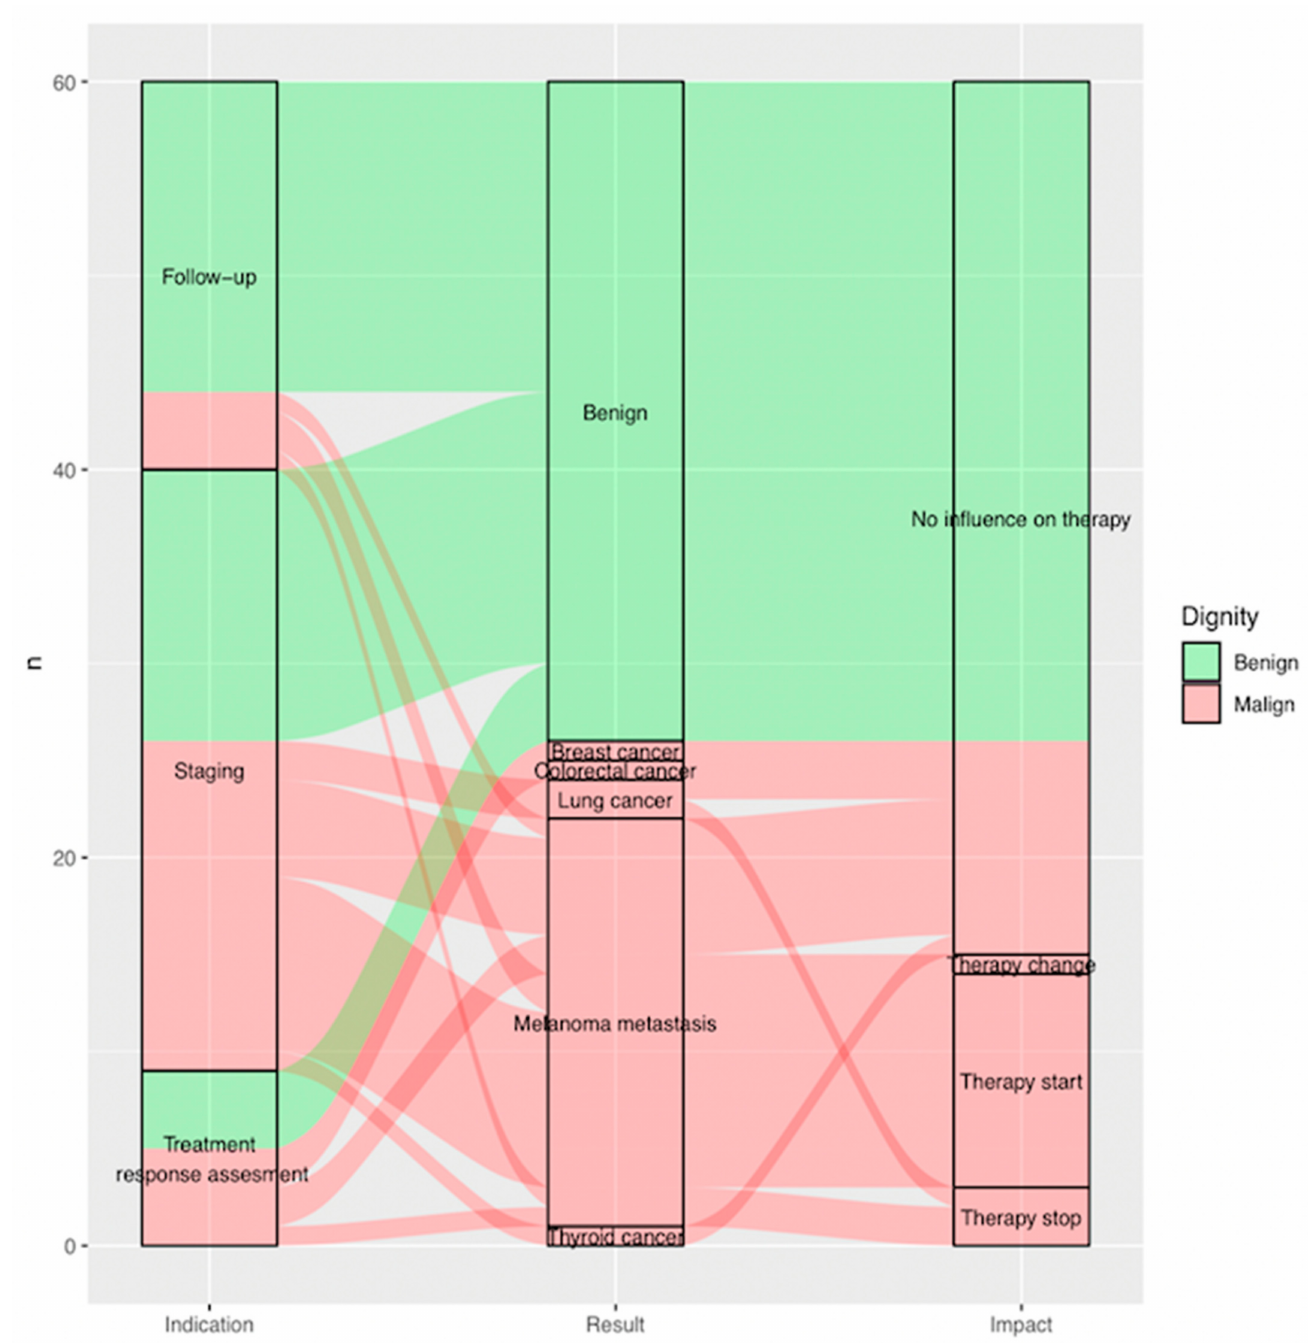
Figure 5. Sankey plot showing, per included indeterminate finding ( n = 60), on the far left, ( a ) indication of FDG-PET/CT scan it was reported on as indeterminate; in the middle, ( b ) result of additional imaging; and on the far right, ( c ) impact of additional imaging on clinical management. Benign findings are displayed in green, malignant findings in red arrows. ( a ) Indication (on the left from the bottom to the top): treatment response assessment ( n = 9; 15.0%), staging ( n = 31; 51.7%) and follow-up ( n = 20; 33.3%). ( b ) Result (in the middle from the bottom to the top): thyroid cancer ( n = 1; 1.7%), melanoma metastasis ( n = 21; 35.0%), lung cancer ( n = 2; 3.3%), colorectal cancer ( n = 1; 1.7%), breast cancer ( n = 1; 1.7%), benign ( n = 34; 56.7%). ( c ) Impact ( on the right from the bottom to the top): therapy stop ( n = 3; 5.0%), therapy start ( n = 11; 18.3%), therapy change ( n = 1; 1.7%) and no influence on therapy ( n = 45;